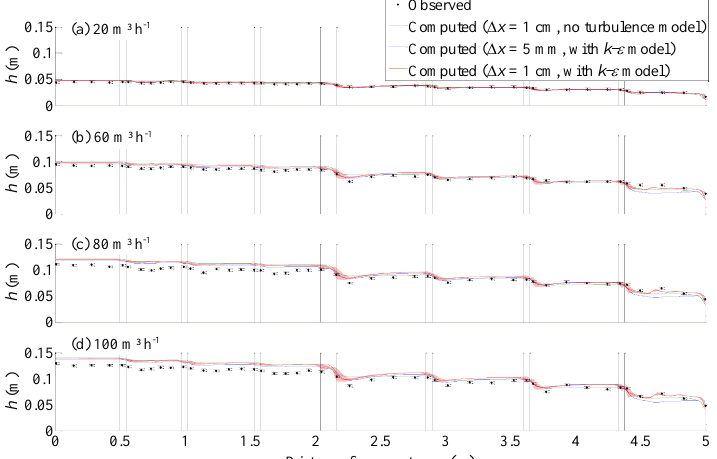
Figure 5. Observed and computed water depths h for inflow discharges varying between 20 and 100 m 3 h − 1 in street C. The shaded area ( (cid:4) ) represents the range of variation in the crosswise direction of the computed water depths ( (cid:49)x = 1cm, with k − ε